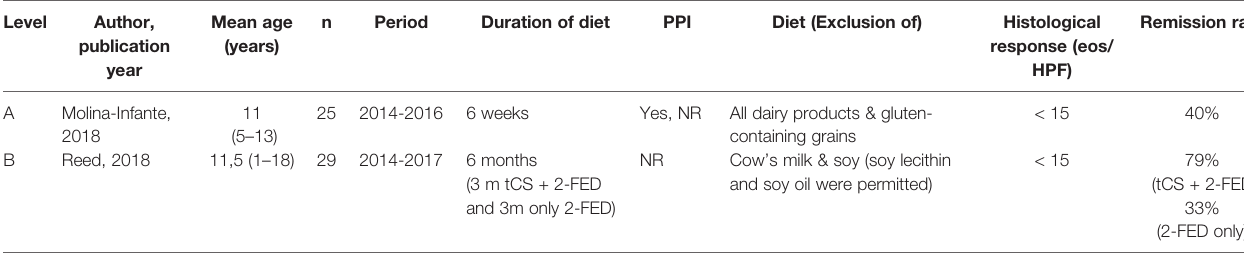
TABLE 6 | Overview of studies on the 2-food elimination diet.